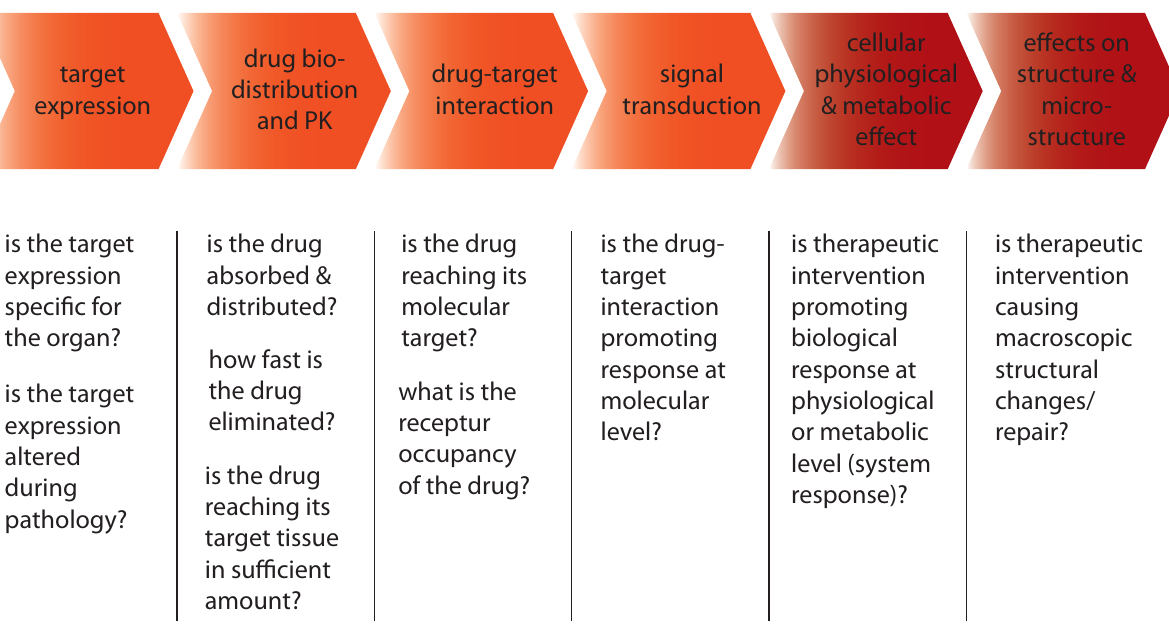
Figure 6. Multimodality imaging in drug discovery: Molecular imaging contributions are indicated in light red and relate to aspects addressing expression, PK and drug effects at a molecular level (receptor interaction and signaling). Physiological and structural readouts of drug efficacy are indicated in dark